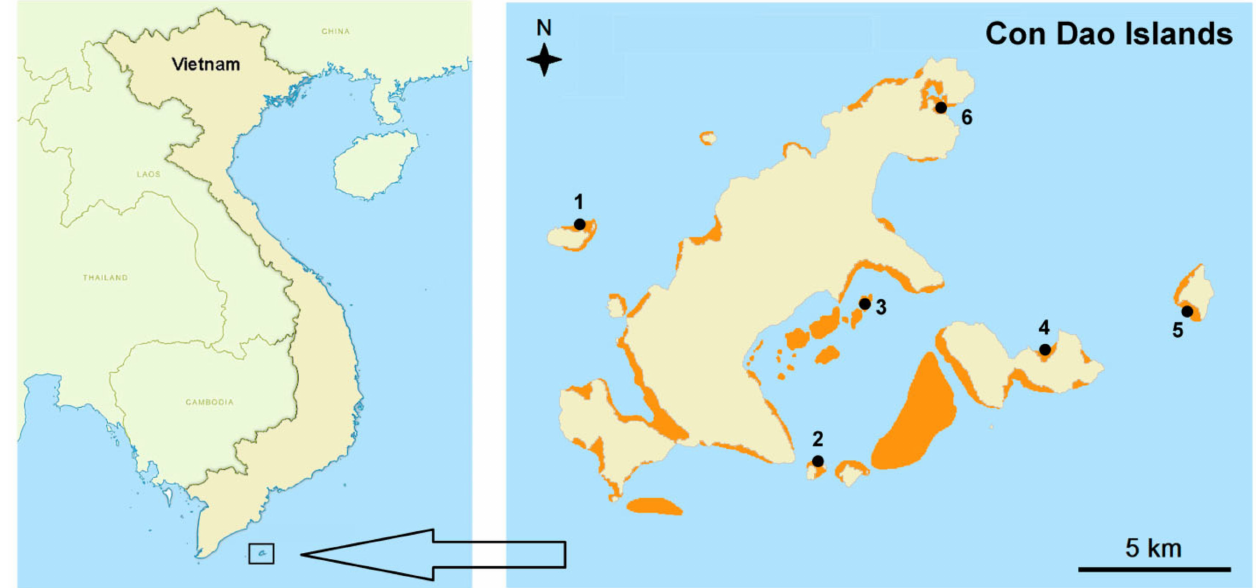
Figure 1. Location of Con Dao Islands and study sites (numbers). Coral reefs are shown in